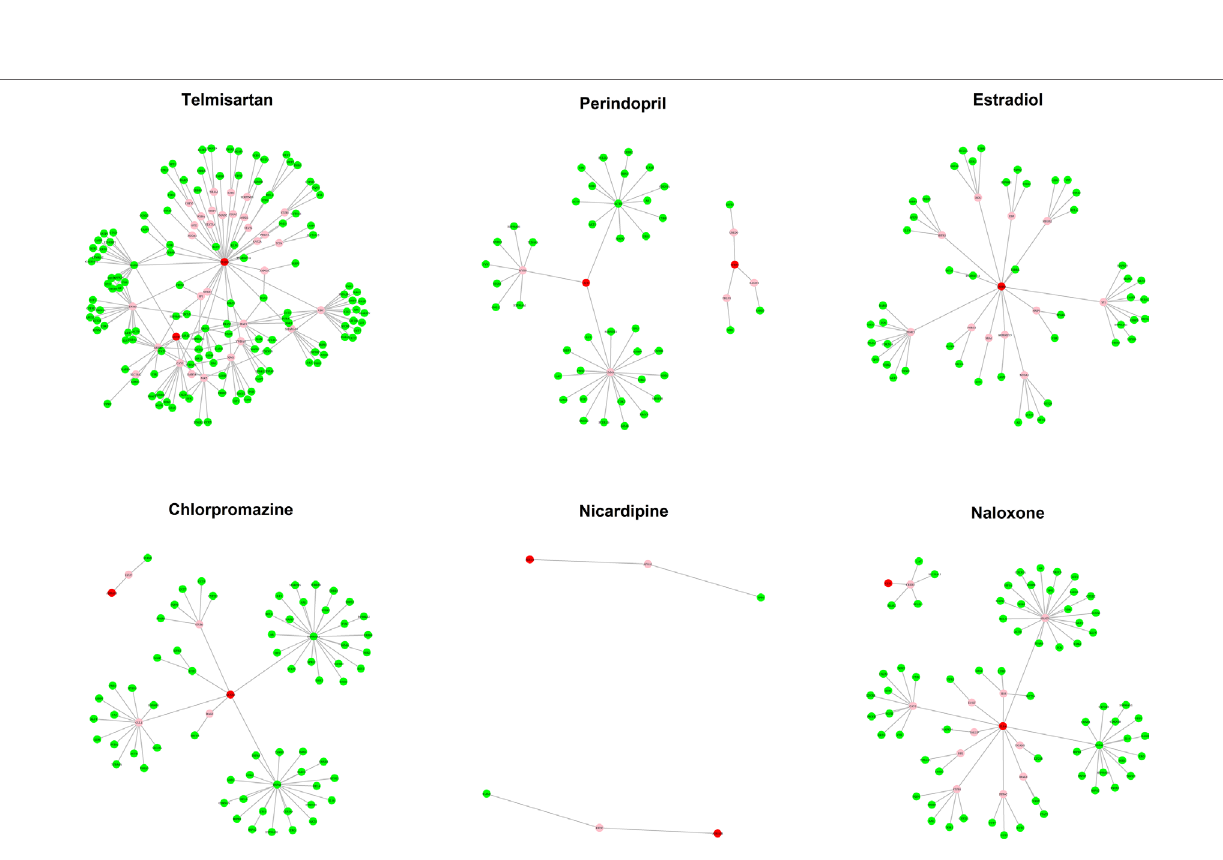
Frontiers in Genetics |